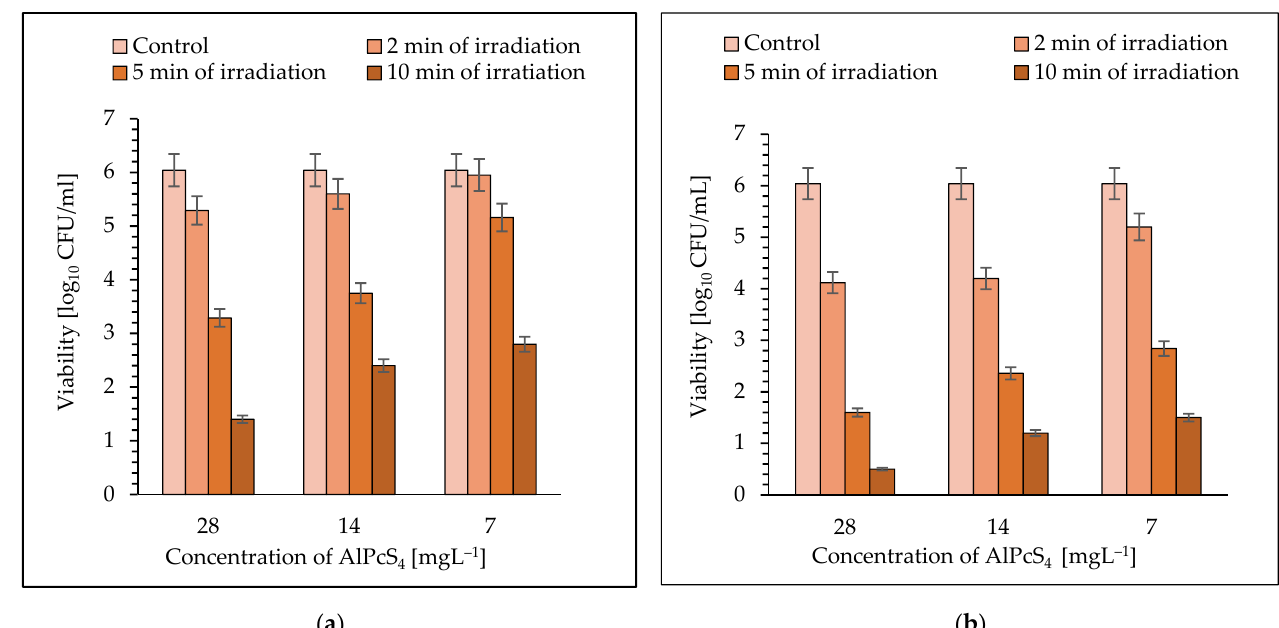
Figure 4. The effect of AlPcS 4 on viability of S. aureus after exposure to laser light for 2, 5, and 10 min. ( a ) laser light ( λ = 650 nm; the radiation power density of 105 mW cm − 2 ); ( b ) laser light ( λ = 650 nm; the radiation power density of 210 mW cm − 2 ). Average SD of three independent experiments is shown. The efficiency of this treatment was considered as statistically significant for all groups ( p <